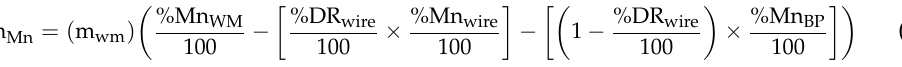
similar, at -5.3 kJ and -4.5 kJ exothermic heat evolved, potentially heating the weld metal